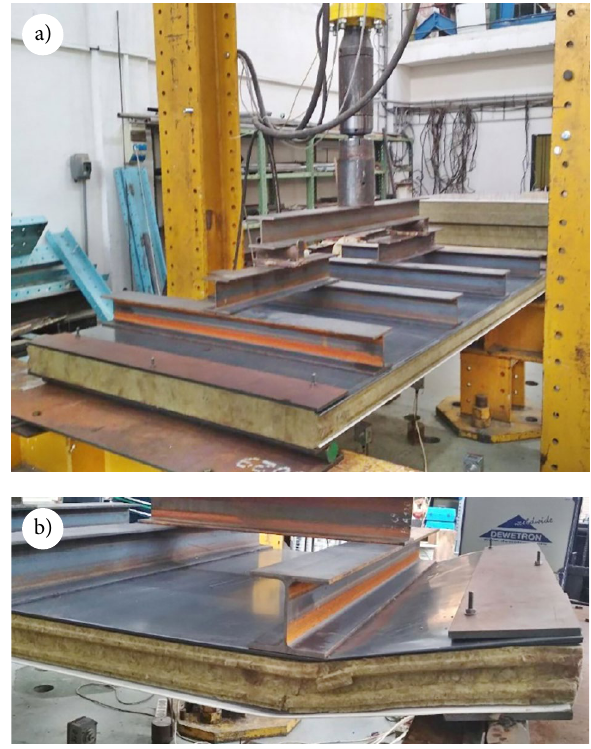
mmFigure 2. Bending tests of the sandwich panel: а) before the test; b) after the